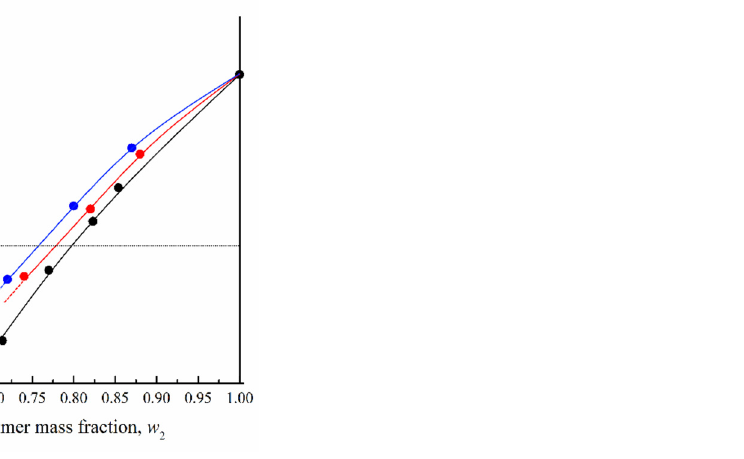
Figure 5. Dependences of PAN T g on the composition of the binary mixture of PAN with NMP (black dots) and pseudobinary mixtures consisting of PAN and mixtures of NMP with water, containing 5 (red dots) and 10 (blue dots) wt.%, determined by DSC in the cooling mode.